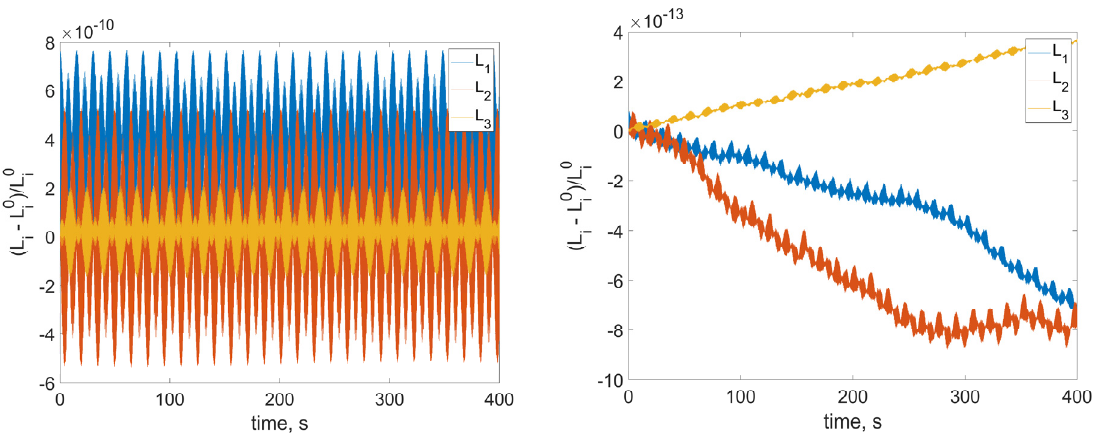
Figure 4. Relative variation of the total angular momentum ( left ) h = 10 − 2 s and ( right ) h = 10 − 3 s).